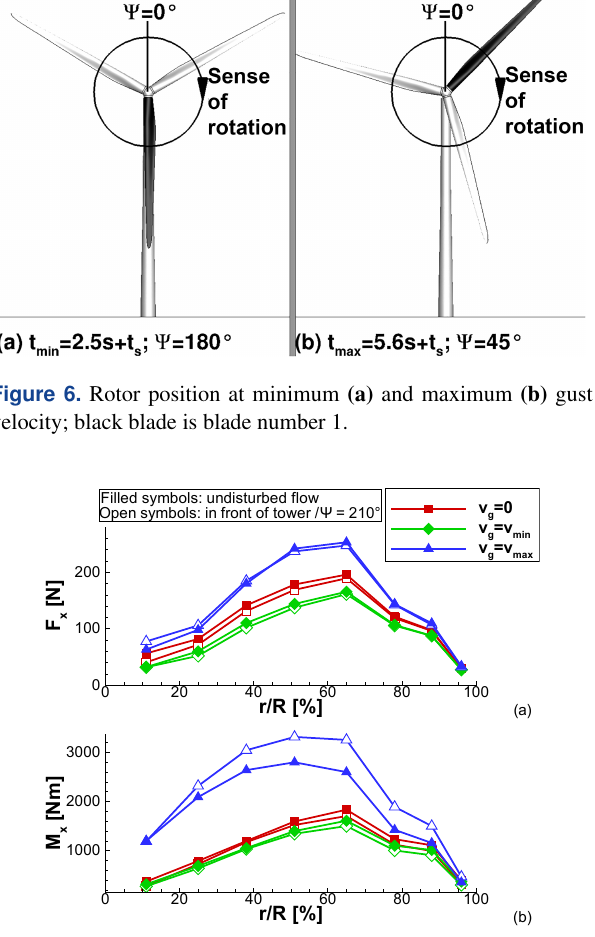
Figure 7. Span-wise distribution of (a) rotor thrust and (b) rotor torque for different azimuth positions at constant inflow and during the gust.